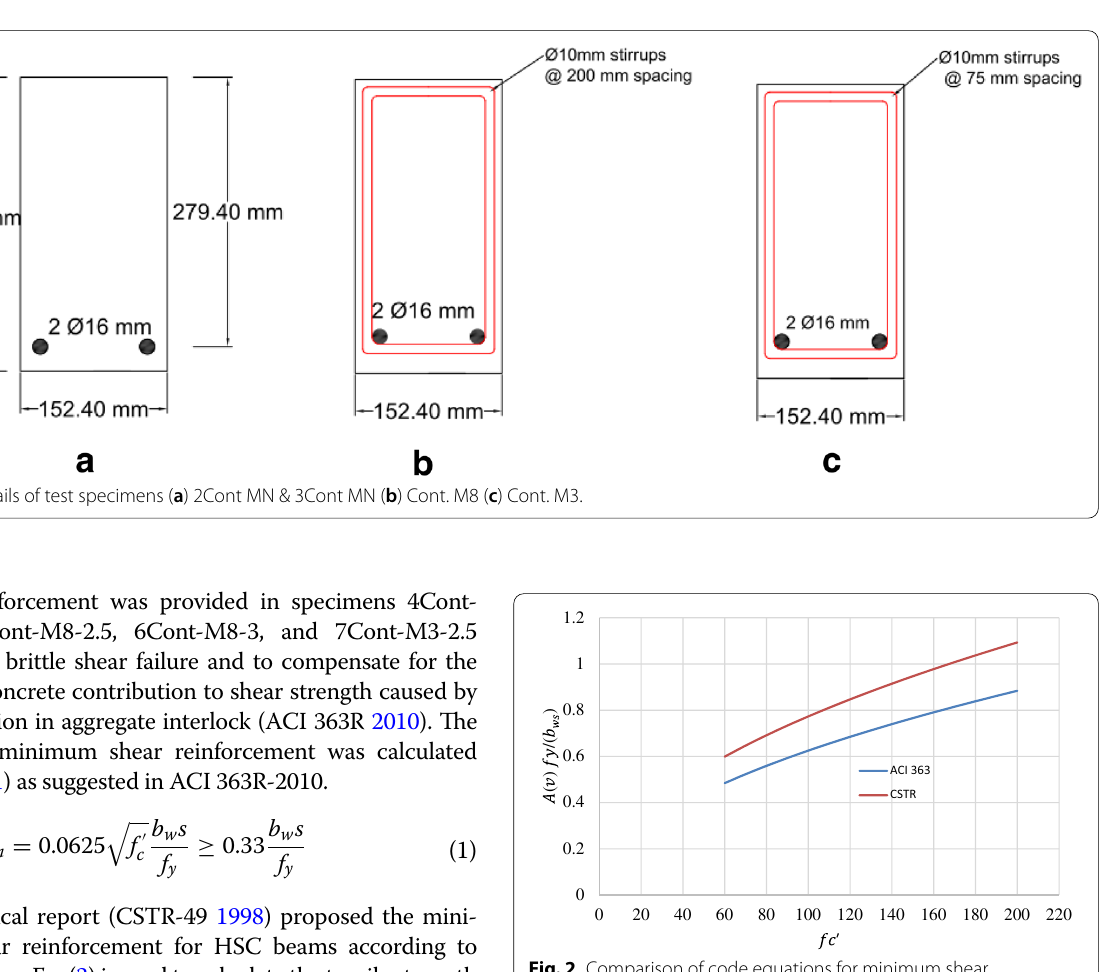
Fig. 2 Comparison of code equations for minimum shear reinforcements in HSC